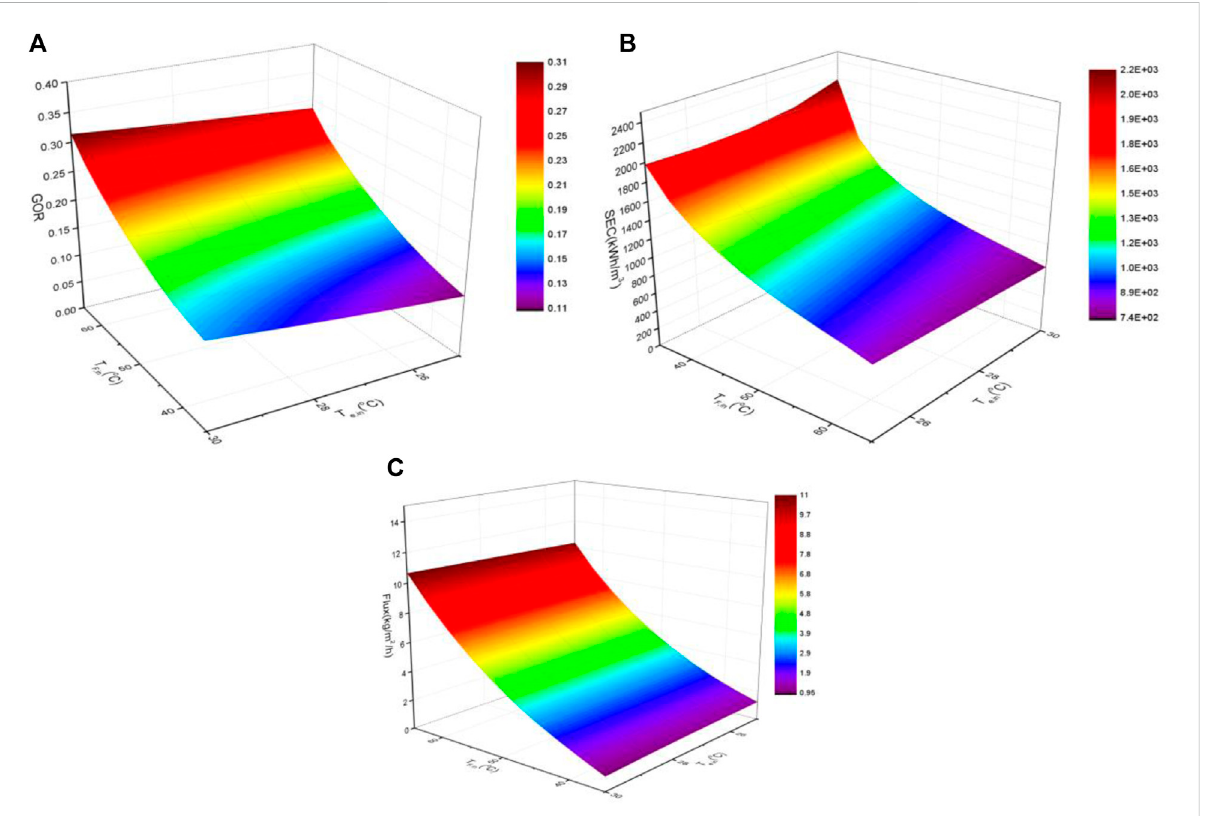
FIGURE 8 EffectsofpermeatetemperatureattheinletoftheevaporatorandfeedwatertemperatureattheinletofDCMDonGOR (A) ,SEC (B) ,and fl ux (C) .